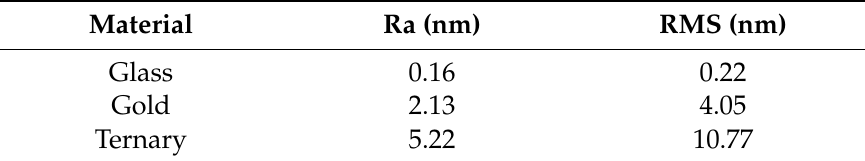
Figure 4. AFM surface morphological images for the ( a ) glass substrate, ( b ) gold thin film, and ( c ) ternary composite thin film, respectively. Table 2. The values for the roughness parameters for glass, gold, and ternary film